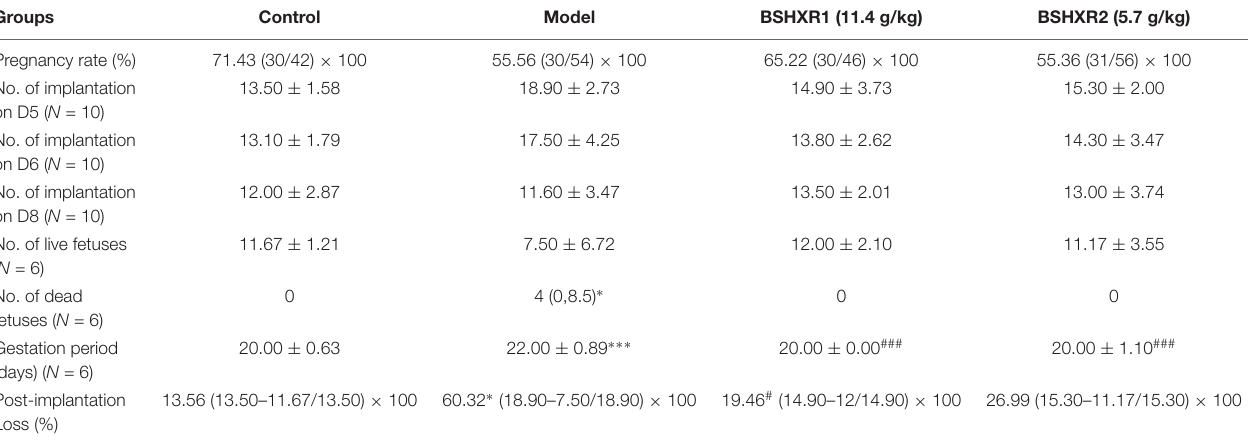
TABLE 3 | Effects of BSHXR on implantation and pregnancy outcome in mice. Groups Control Model